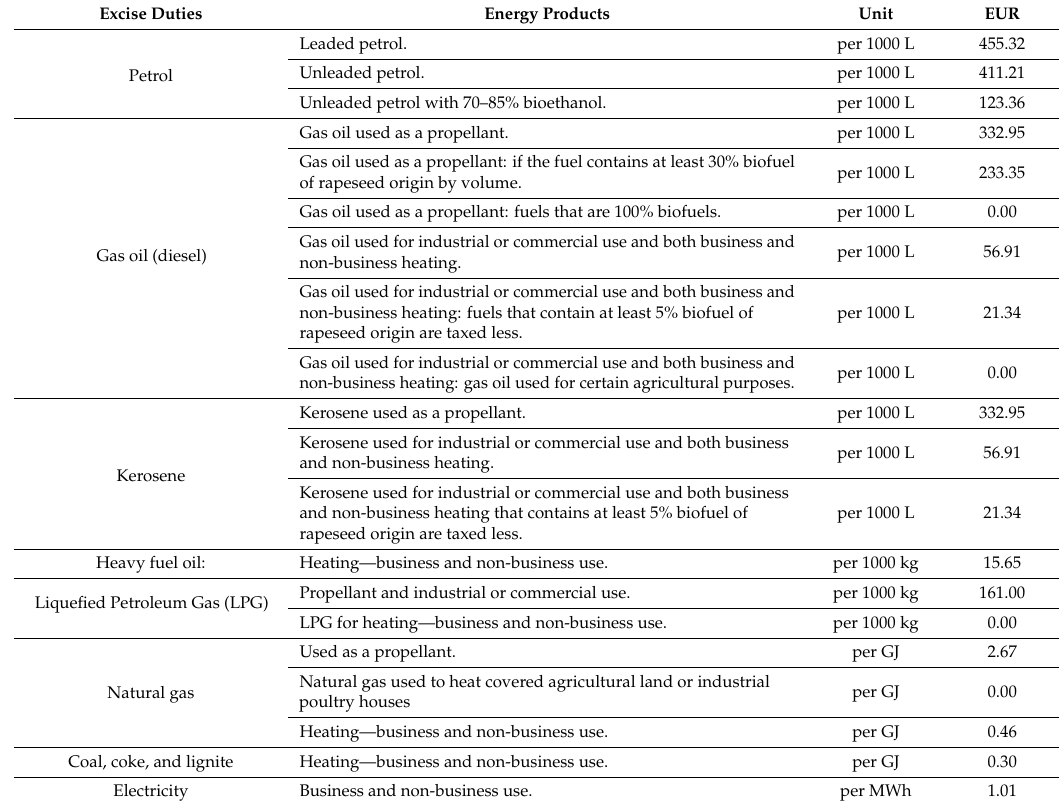
Table 3. Excise duties in Latvia, 2015